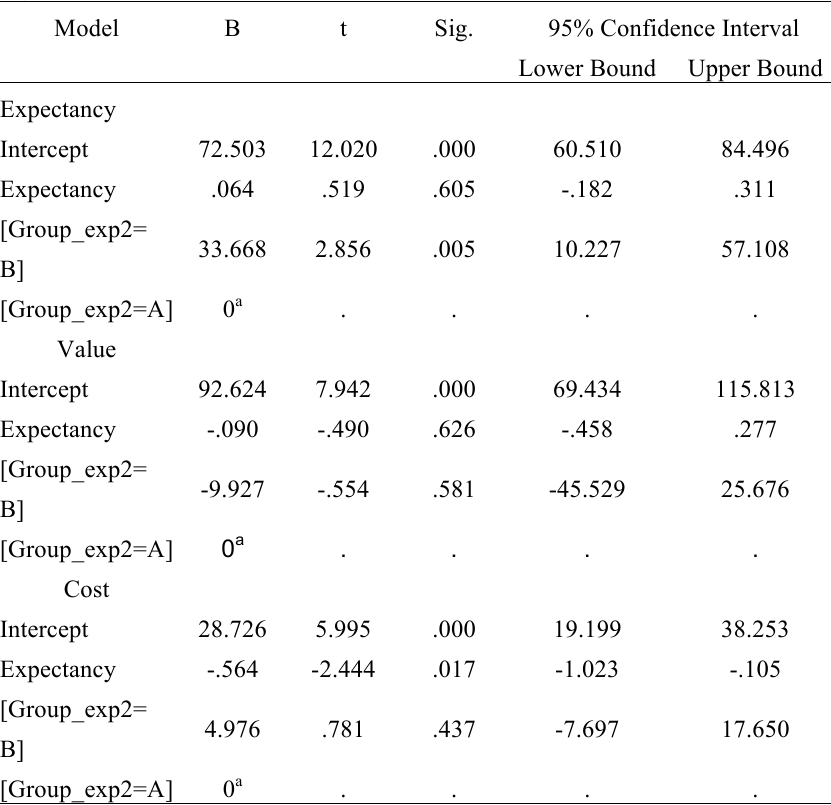
Differences between groups A and B in the Expectancy, Value and Cost Scale (post-